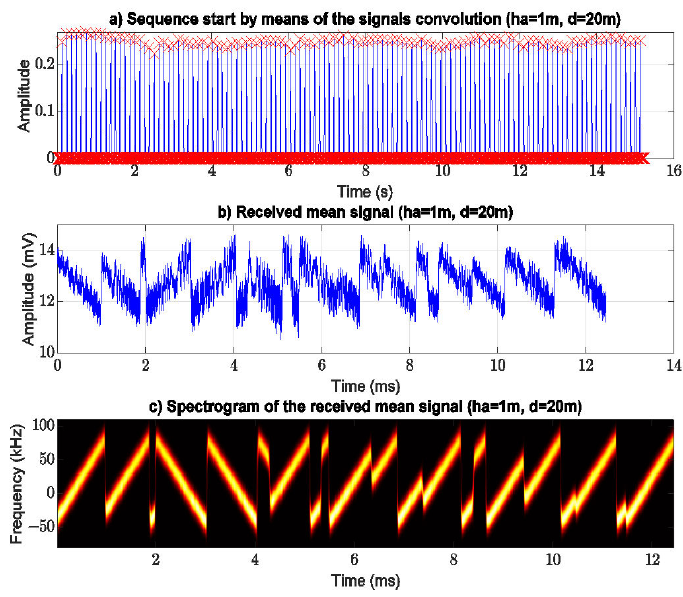
Figure 9. Signal processing to obtain the mean frame of 100 chirp’s frame, ( a ) the red markers show the start of each frame (algorithm 1 point 6), ( b ) mean frame (algorithm 1 point 7), and ( c ) mean frame